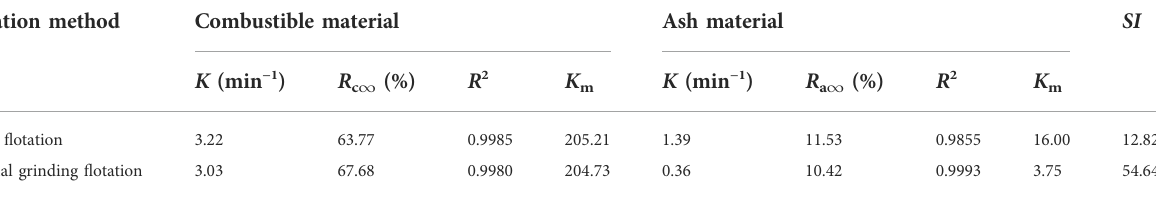
versus time under the methods of direct fl otation and optimal grinding fl otation.